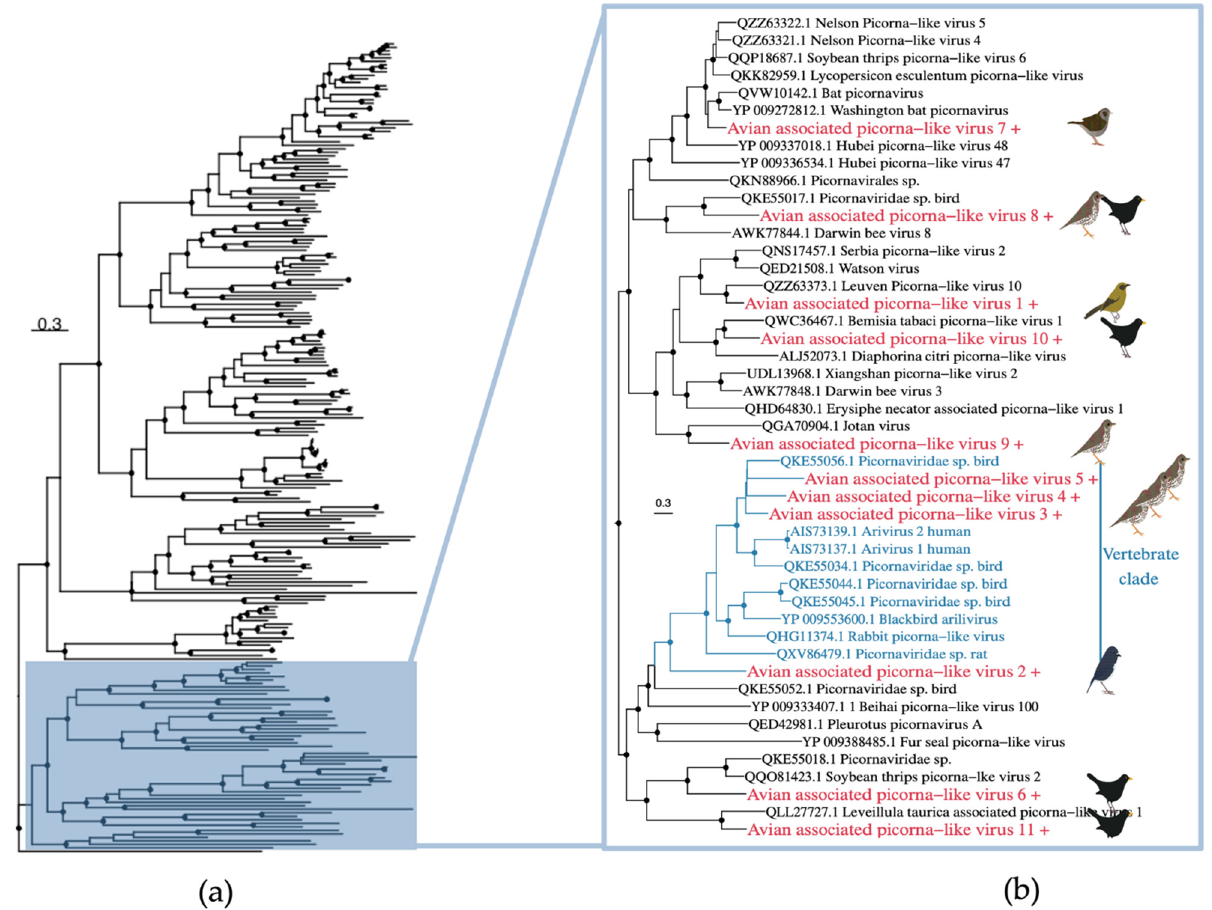
Figure 10. ( a ) Phylogeny of Picornaviridae based on the RNA-dependant RNA polymerase gene (alignment length of 2139 amino acids). ( b ) Magnification of a clade containing the viruses from this study. A clade of vertebrate viruses is shown in blue. Colours and symbols as shown in Figure 5.